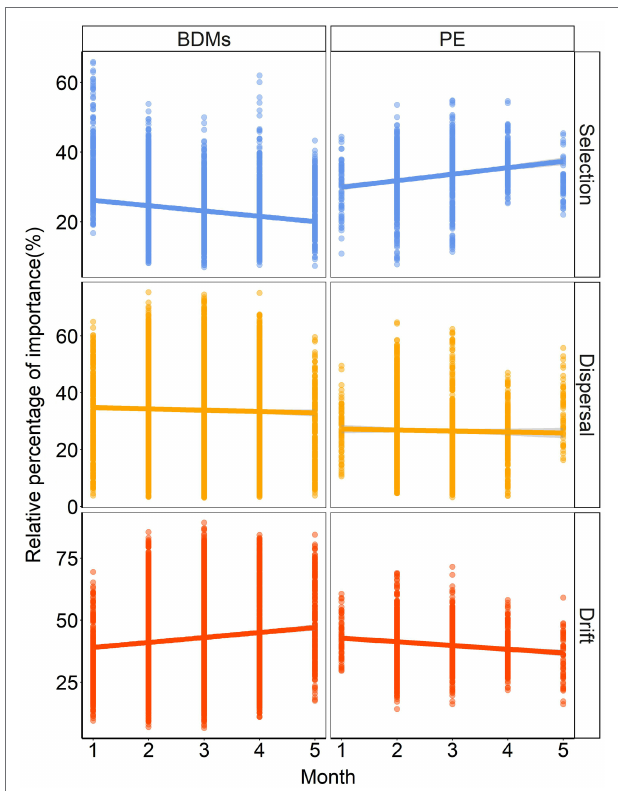
FIGURE 5 | The assembly process of plastisphere microbiota based on infer Community Assembly Mechanisms by Phylogenetic-bin (iCAMP) in BDMs and